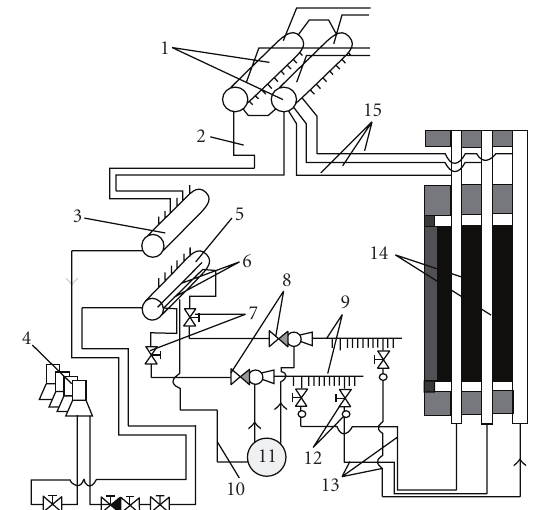
Figure 2: Ignalina NPP model nodalization scheme [21]. inference method which requires no prior knowledge about the distribution function of the underlying population